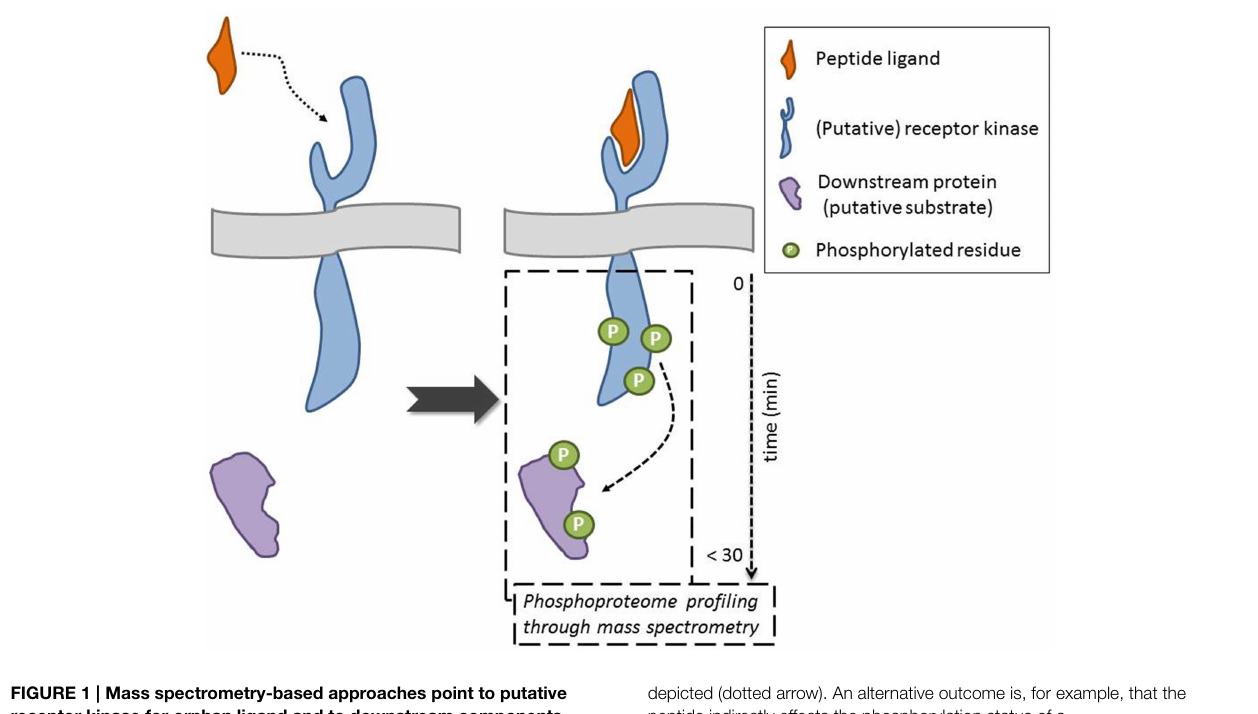
FIGURE 1 | Mass spectrometry-based approaches point to putative receptor kinase for orphan ligand and to downstream components and/or potential substrates following ligand binding through evaluation of changes in the phosphorylation status of proteins. The ideal scenario, where indeed the peptide interacts with the receptor, is